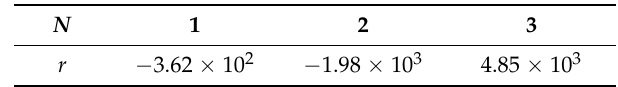
Table 2. Magnitude comparison between the net mass transfer and the diffusion